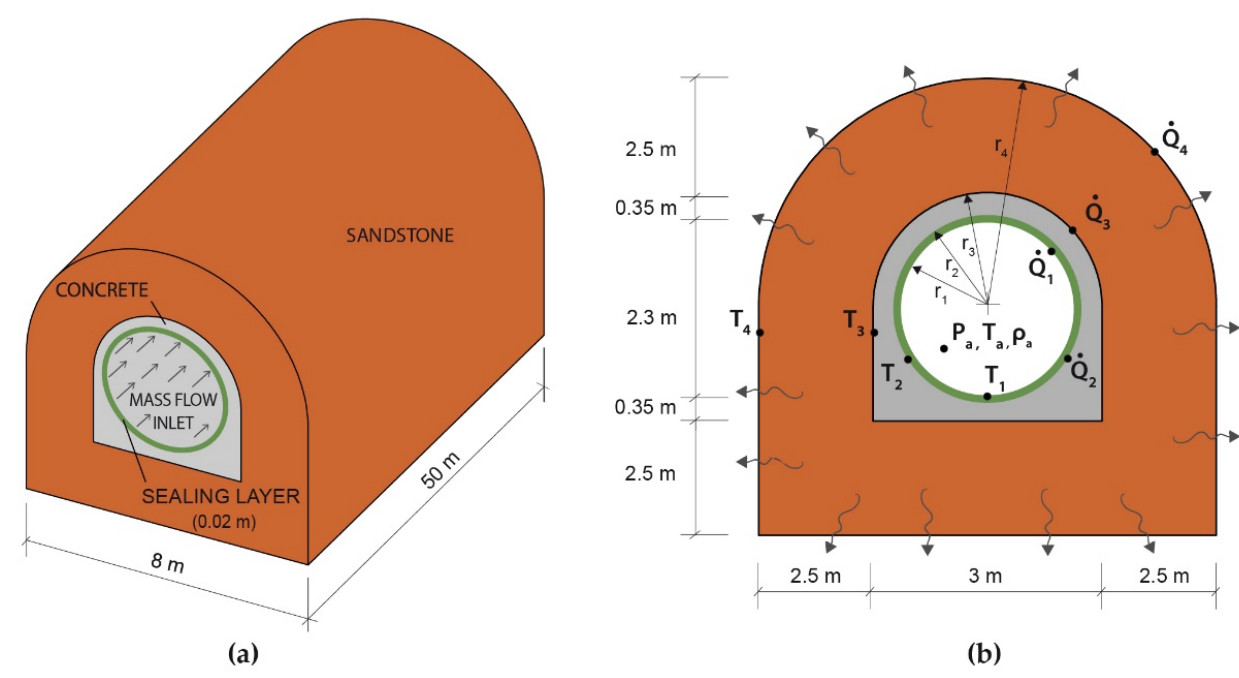
Figure 2. Scheme of the deep tunnel with a sealing layer, concrete lining and sandstone rock mass. ( a ) 3D model (not to scale); ( b ) Cross section.